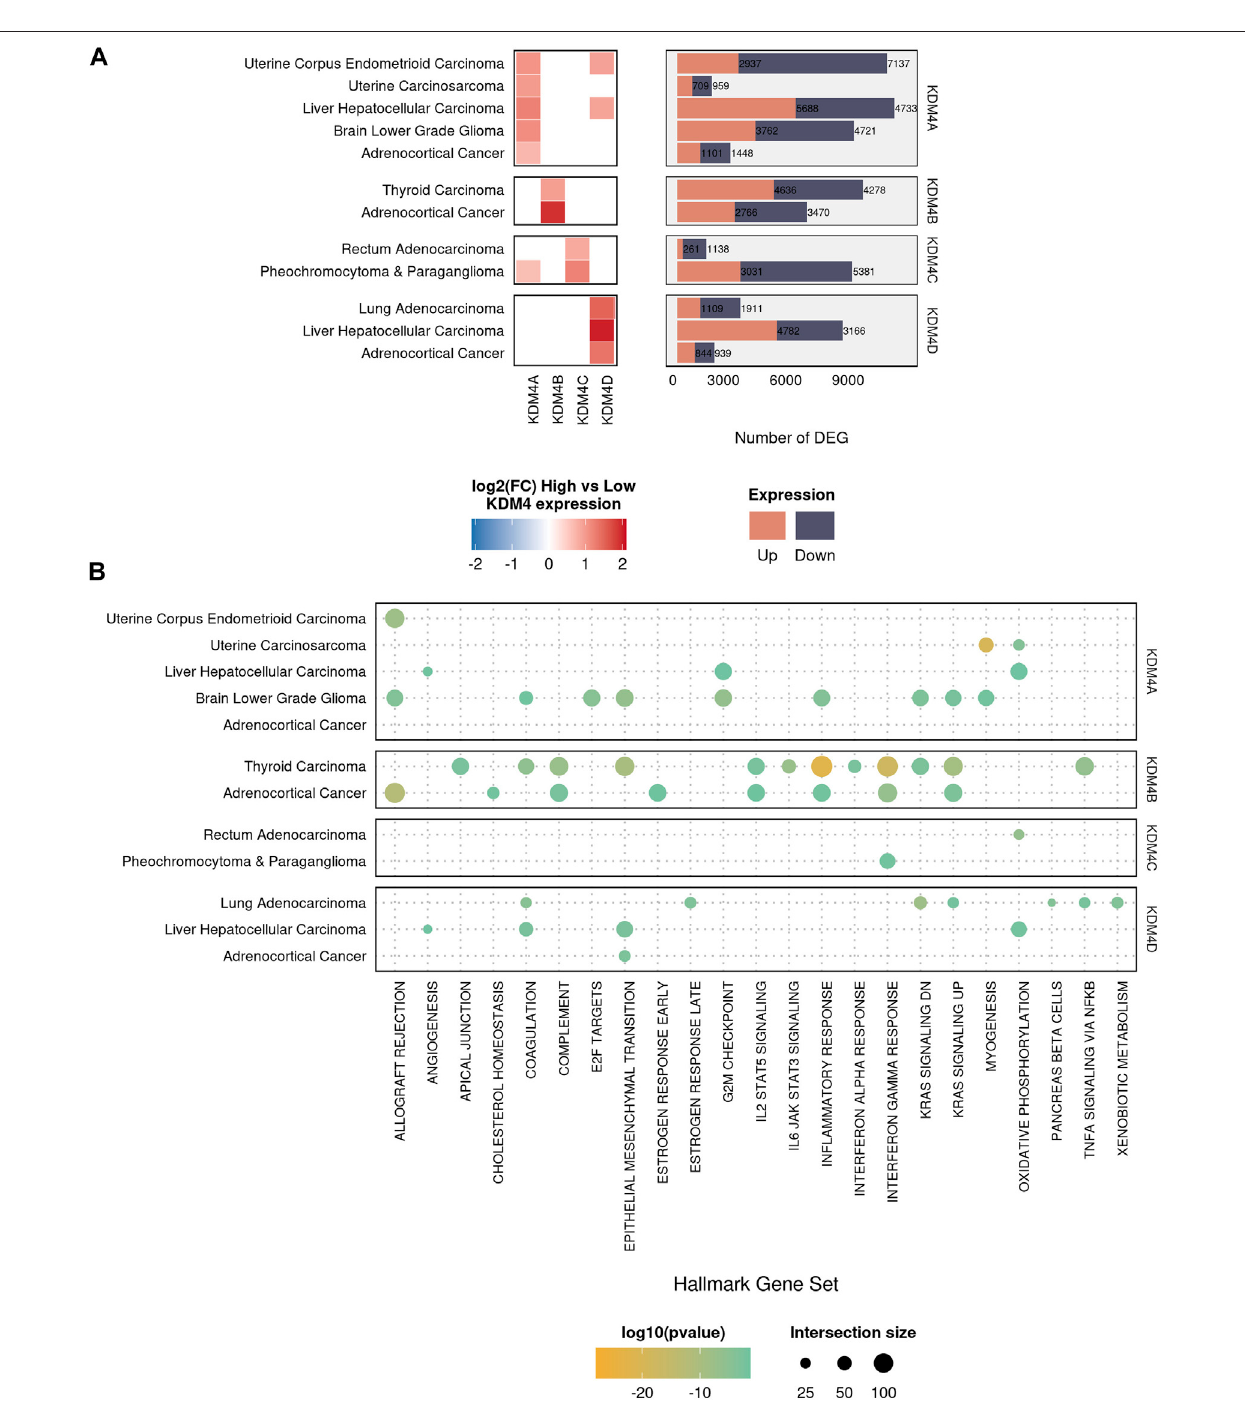
FIGURE 2 | Differential expression and enrichment analysis of the KDM4 family. (A) The left panel of squares represents the 12 types of tumors where the deregulation of the KDM4 subfamily is of bad prognosis. The differential expression analysis was performed comparing High-KDM vs. Low- KDM samples. Color intensity is related to the log2(FC). The right panel represents the number of differentially expressed genes (DEG) for each comparison. (B) Hallmarks of Cancer enrichment analysis for the DEG in each sample. Color intensity represents the pvalue and size of the intersection